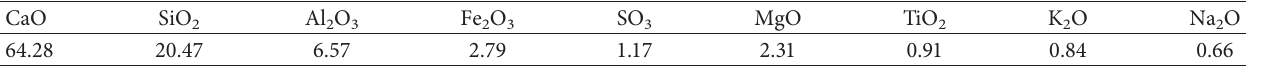
Table 1: Chemical composition of OPC (%).